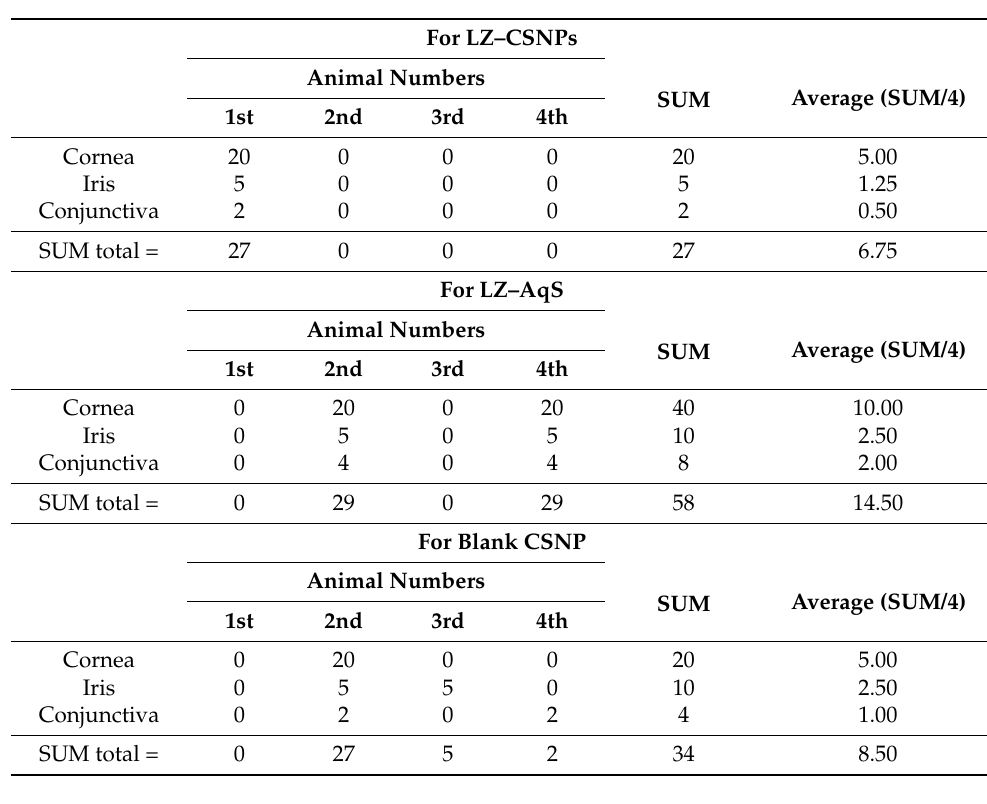
Table 6. The calculation of the Maximum Mean Total Score (MMTS) based to the obtained scores as mentioned